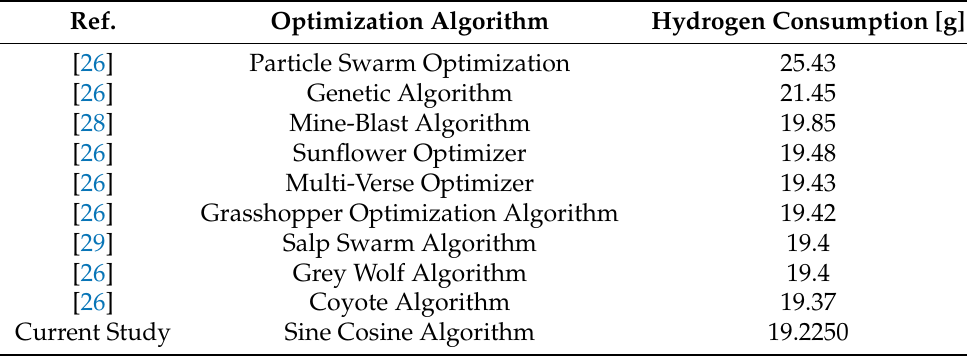
Table 7. Results of optimization methods applied in the literature.